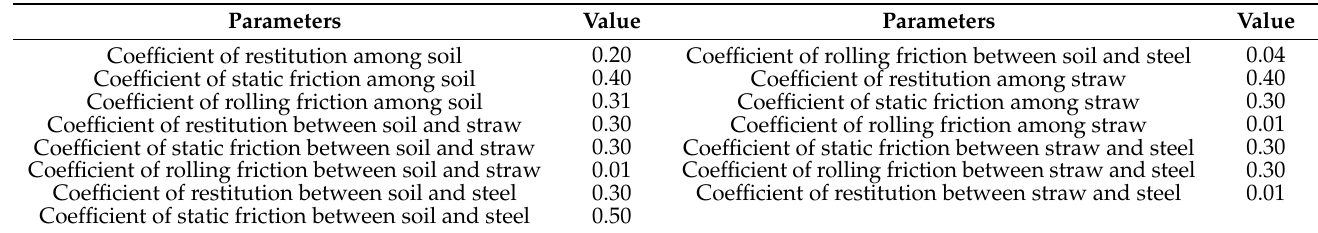
Table 1. Parameter settings for EDEM simulation.